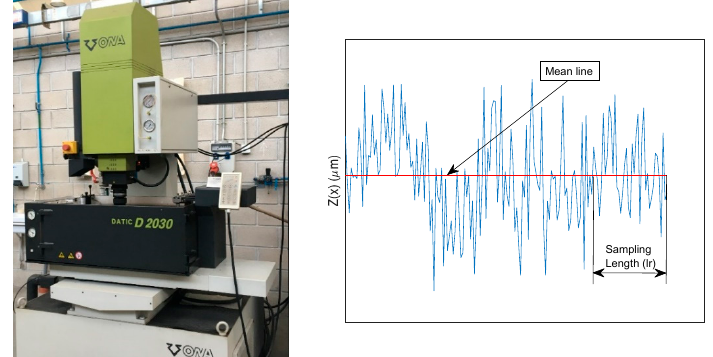
Figure 31. EDM machine ONA Datic D-2030-S, Roughness profile Z(x) (µm) for determination of Ra parameter and Electrode Wear.